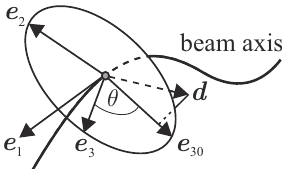
Figure 2. In order to have a uniquely defined orientation of the cross section about the beam axis direction e 1 = r 0 director d is utilized. The local frame ( e 1 , e 2 , e 3 ) is defined by the normalized projection e 30 of d into the normal plane of e 1 , and a subsequent rotation around a torsional angle θ